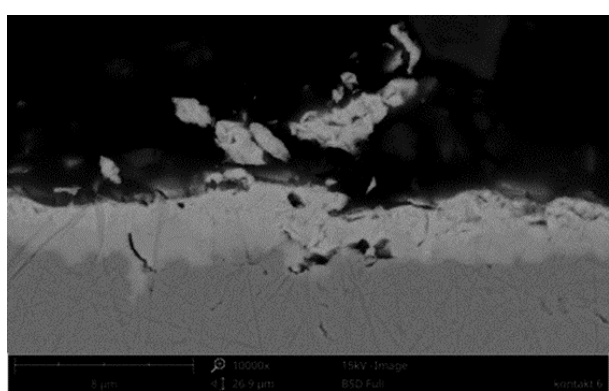
Fig. 5. Scanning microscope image of sample number 3 – differences in coating thickness with continuity, visible delamination at the border of coating and core material